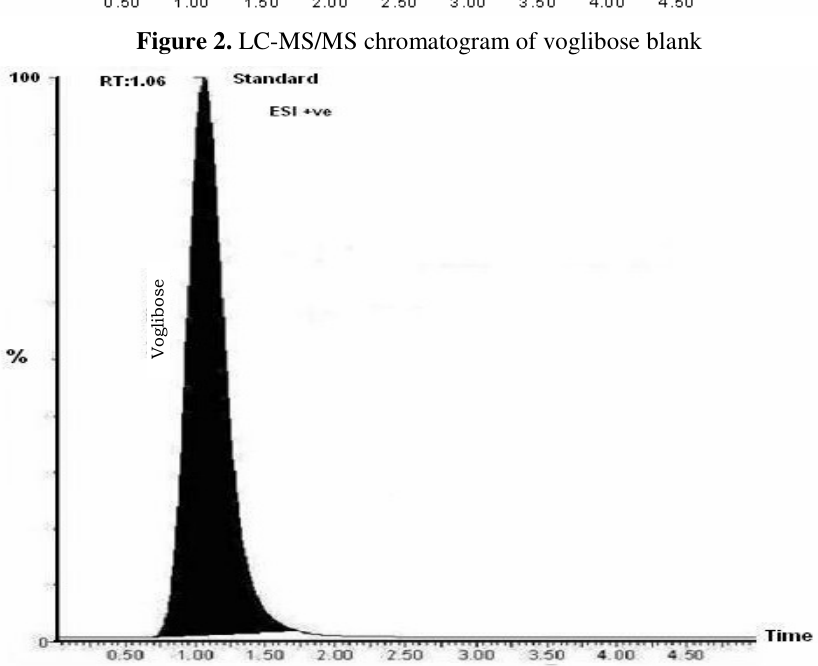
Figure 2. LC-MS/MS chromatogram of voglibose blank